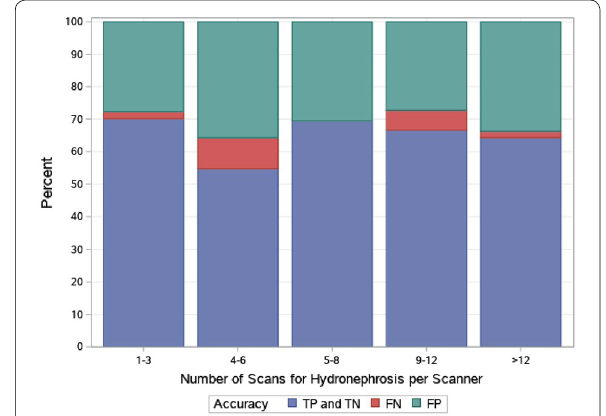
Fig. 3 Accuracy of POCUS with formal imaging with increasing scanning experience ( TP true positive, TN true negative, FP false positive, FN false negative)